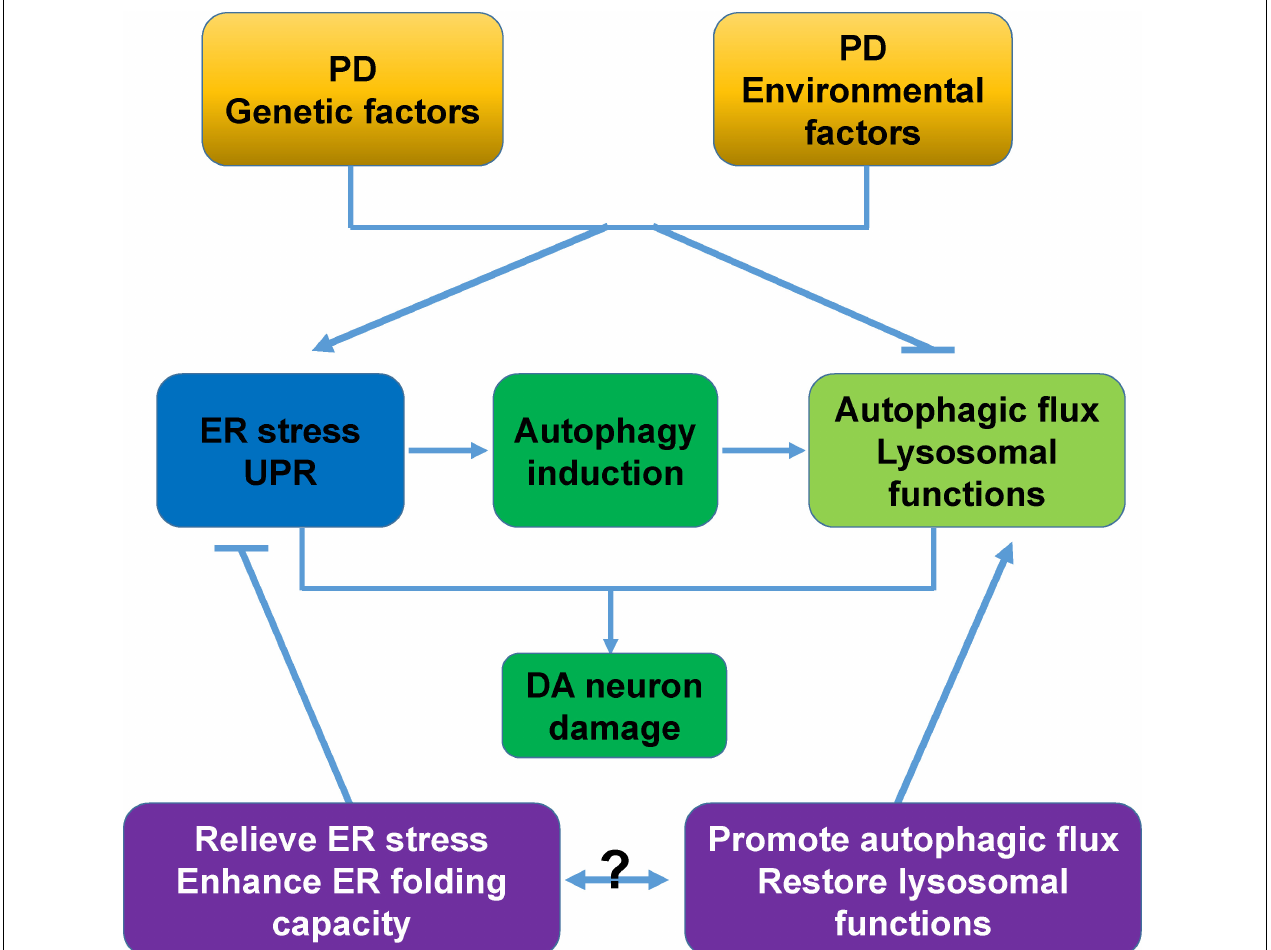
FIGURE 5 | Proposed model of cross-links between ER stress, autophagy, and DA neurodegeneration. PD-associated genetic and environmental factors trigger ER stress, and ER stress activates the UPR and induces autophagy to alleviate cellular stress. However, these PD-associated factors commonly block autophagic flux and impair lysosomal functions, and these changes synergistically cause severe damage and degeneration of DA neurons. Relieving ER stress/UPR, enhancing the ER folding capacity, promoting autophagic flux, and restoring lysosomal functions are neuroprotective for PD. The combined intervention of ER stress/UPR and autophagy would be a more attractive therapeutic approach for